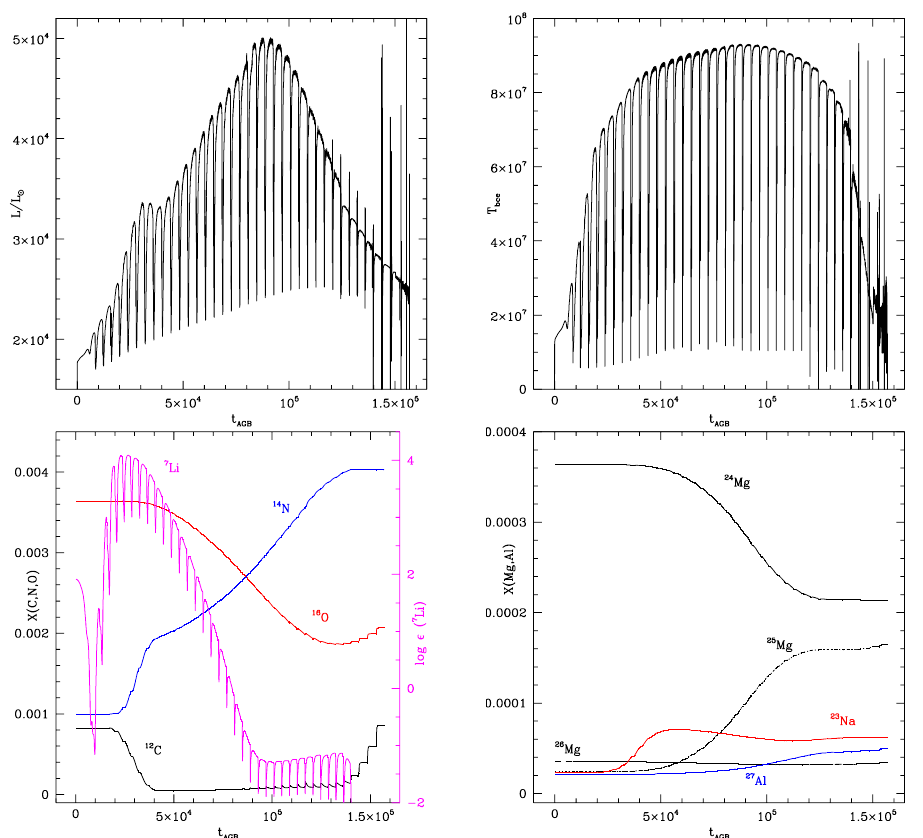
Figure 3. Time variation of luminosity ( top , left panel), temperature at the base of the enve- lope ( top , right ), CNO mass fractions and the surface lithium in the log (cid:101) ( 7 Li ) scale (where log (cid:101) ( 7 Li ) = 12 + log [ n ( 7 Li ) /n ( H )] , scale on the right) ( bottom , left ), and Na-Mg-Al abundances ( bottom , right ) of a 5 M (cid:12) model star of metallicity Z = 8 × 10 − 3